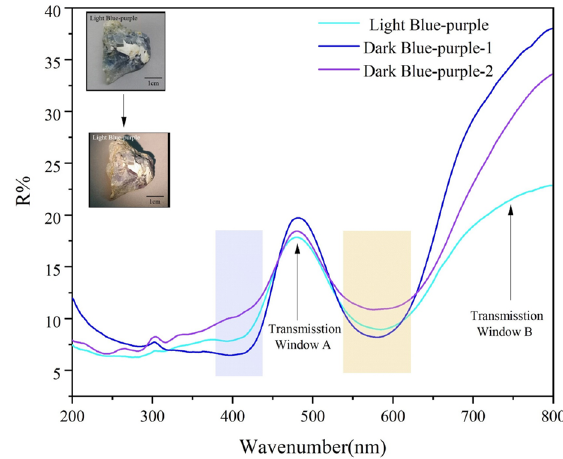
Figure 9. UV-Vis spectrum of color-changing fluorite.